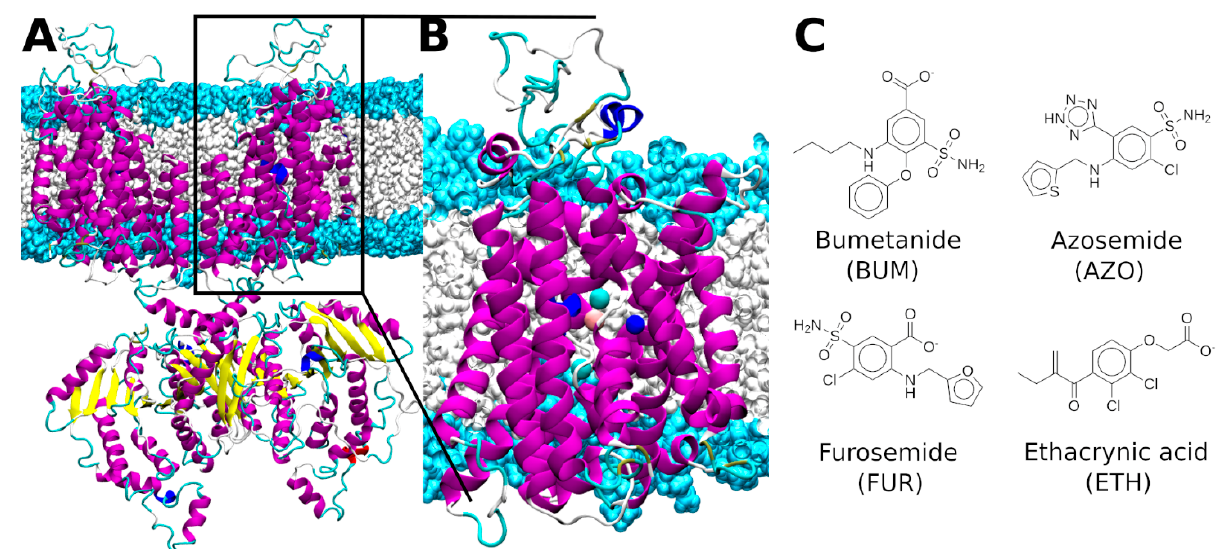
Figure 1. ( A ) Full length dimeric structure of zebrafish (z)NKCC1. ( B ) The monomeric transmembrane model of zNKCC1. NKCC1 is depicted as magenta, yellow, blue, cyan, and white new cartoons for α -helix, β -sheet, 3 10 -helix, turn and coil elements, respectively. The Cl − , Na + , and K + ions are shown as cyan, blue, and orange van der Waals spheres, respectively. The hydrophilic head groups and hydrophobic tails of the phosphatidylcholine lipids are depicted in light blue and white surfaces, respectively. ( C ) Sketches of the four investigated NKCC1 inhibitors.